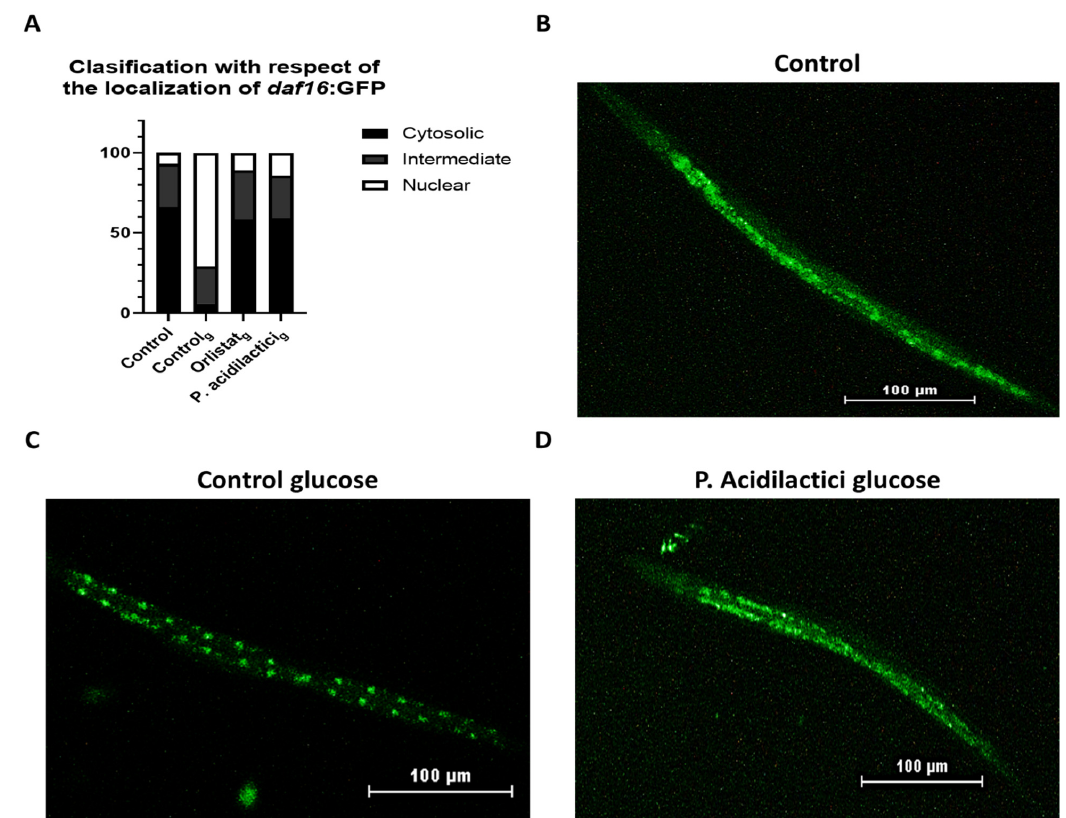
Figure 3. Classification of worms with respect of daf-16 :GFP localization ( A ). Cytosolic daf-16 expression of control worms in a NGM medium ( B ). The addition of glucose to the medium results in a nuclear localization of daf-16 ( C ). Supplementation with pA1c reverts the daf-16 -nuclear translocation effect of high-glucose and returns daf-16 into the cytosol ( D ).